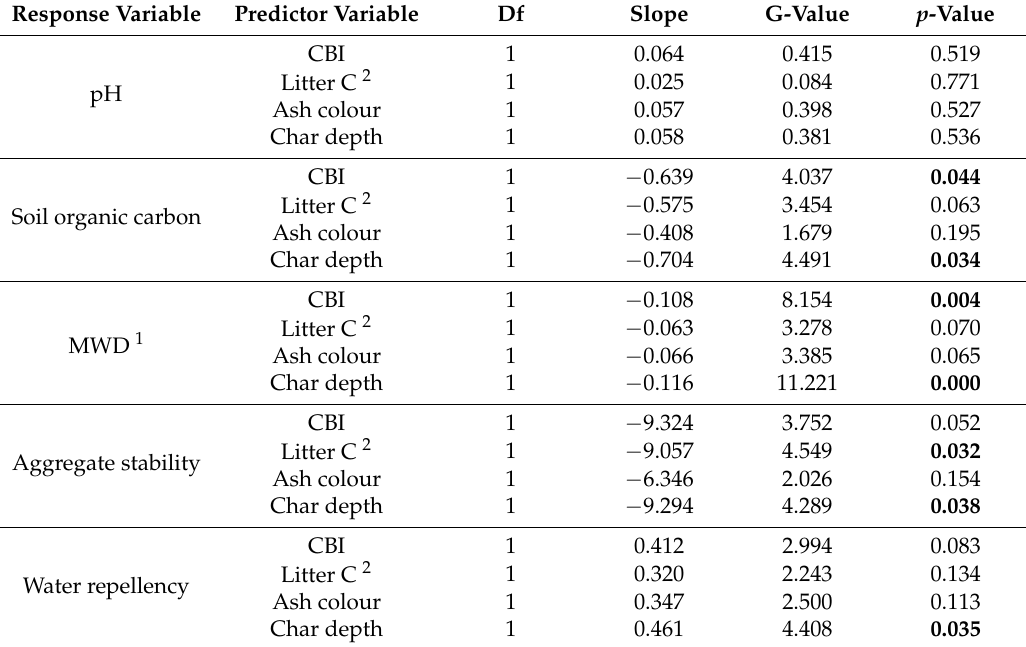
Table 4. Generalised linear model (GLM) results for the relationship between soil properties and soil burn severity (CBI) and individual visual indicators (litter consumption, ash colour and char depth).